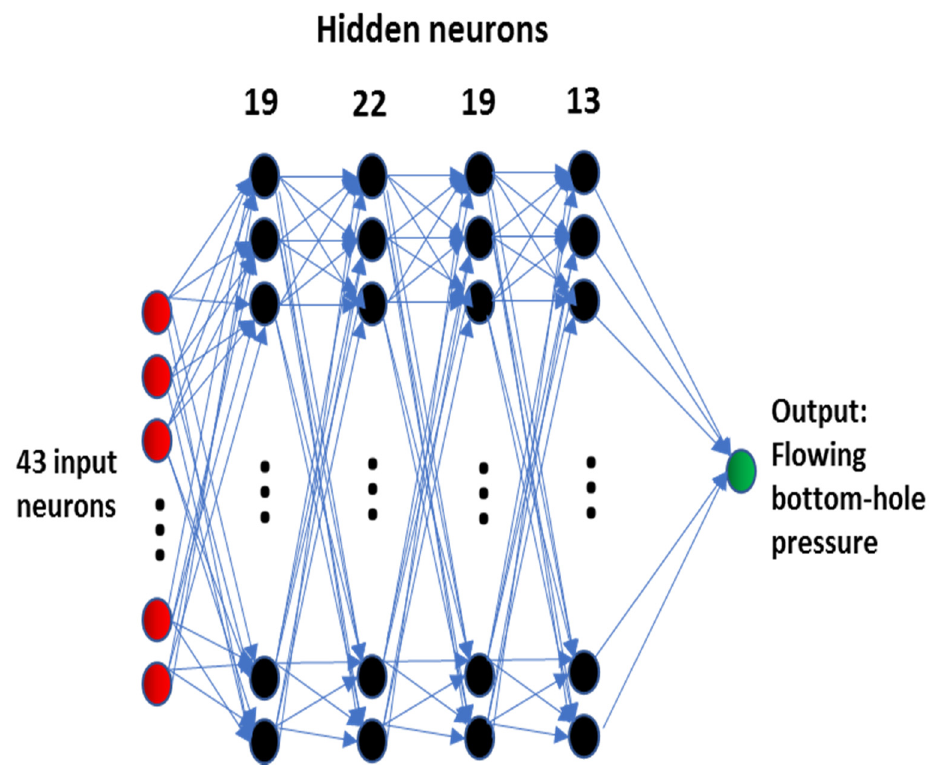
Figure 17. Architecture of the ANN-based wellbore hydraulics model. Table 5. Validation of the wellbore hydraulics model with the field data [11].